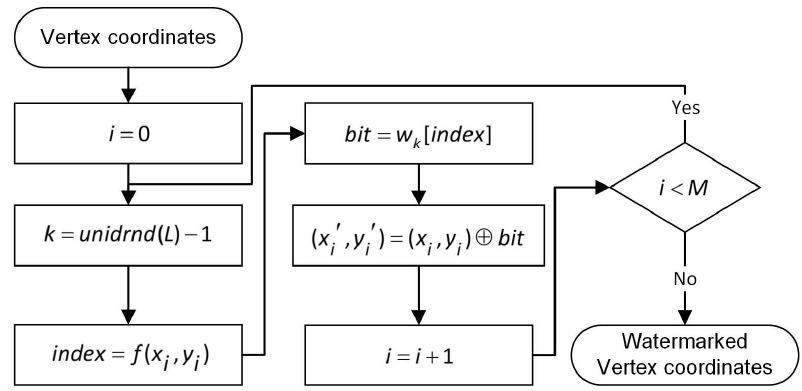
Figure 4. An example of dividing data using three non-repetitive vertex sets.